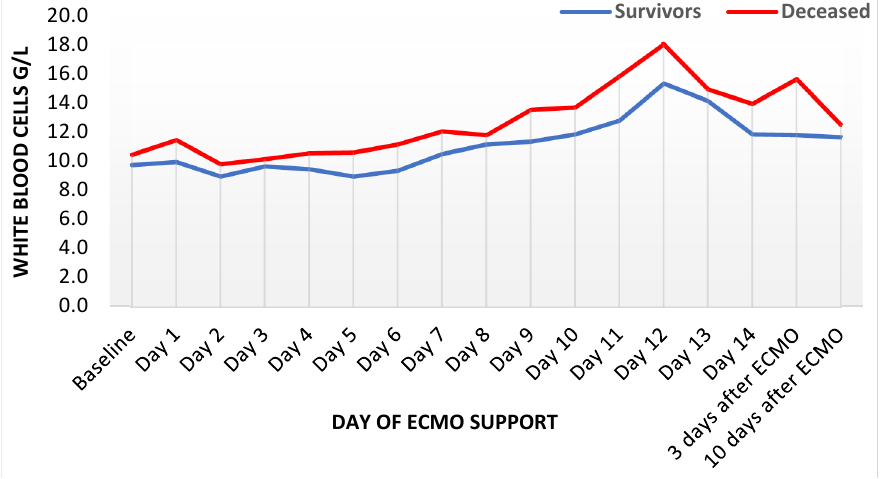
Figure 3. Trends of white-blood-cell count during ECMO support, presented as median values ( n = 435). ECMO: extracorporeal membrane oxygenation.